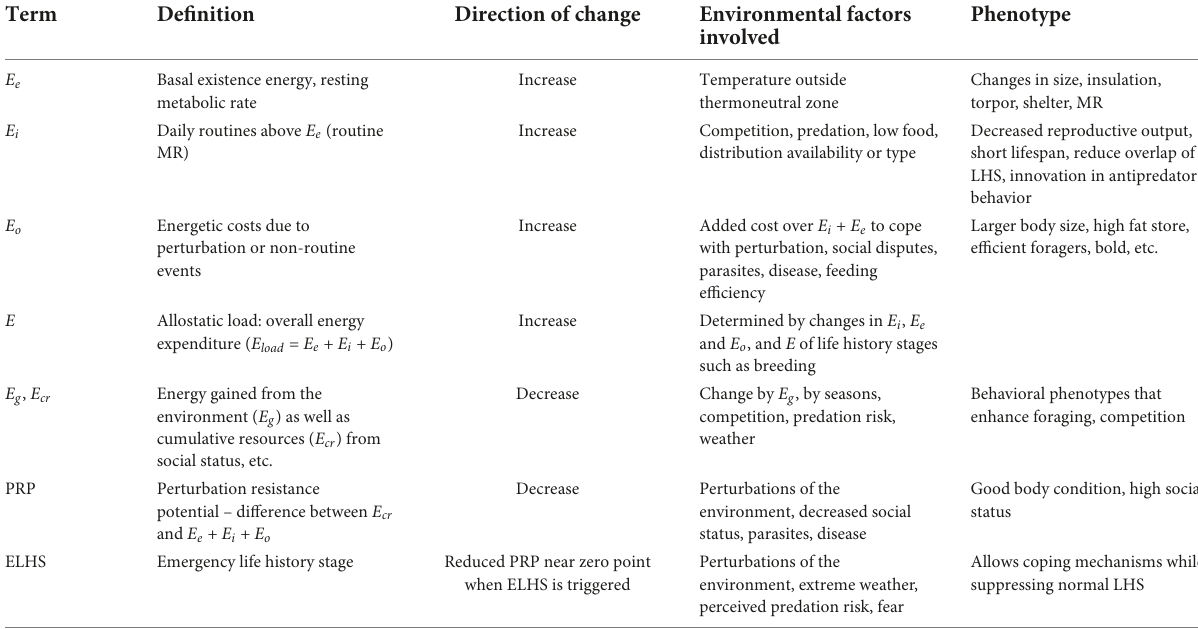
TABLE 1 Environmental factors and allostasis, definitions and